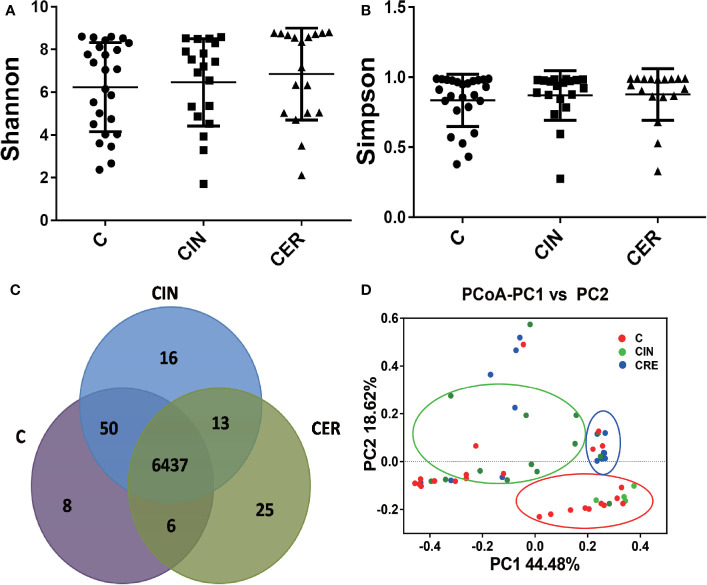
Differences in the alpha diversity and beta diversity of the vaginal flora among these three groups. The Shannon index (A) (P = 0.2609), Simpson index (B) (P = 0.2245), and Scalar-Venn (D) reveal the alpha diversity of the vaginal flora. The difference in alpha diversity has no statistical significance. The Venn result shows that there are 6573 OTUs in the C group, 6516 OUTs in the CIN group and 6517 OUTs in CER group. The PCoA analysis (C) reveals the PCoA beta diversity index. C: Control group, a group of women who have no problem in gynecology. CER: Cervical cancer group, a group of women who were diagnosed a cervical cancer by pathological biopsy. CIN: Cervical intraepithelial neoplasis group, a group of women were diagnosed a by pathological biopsy or cytological test.